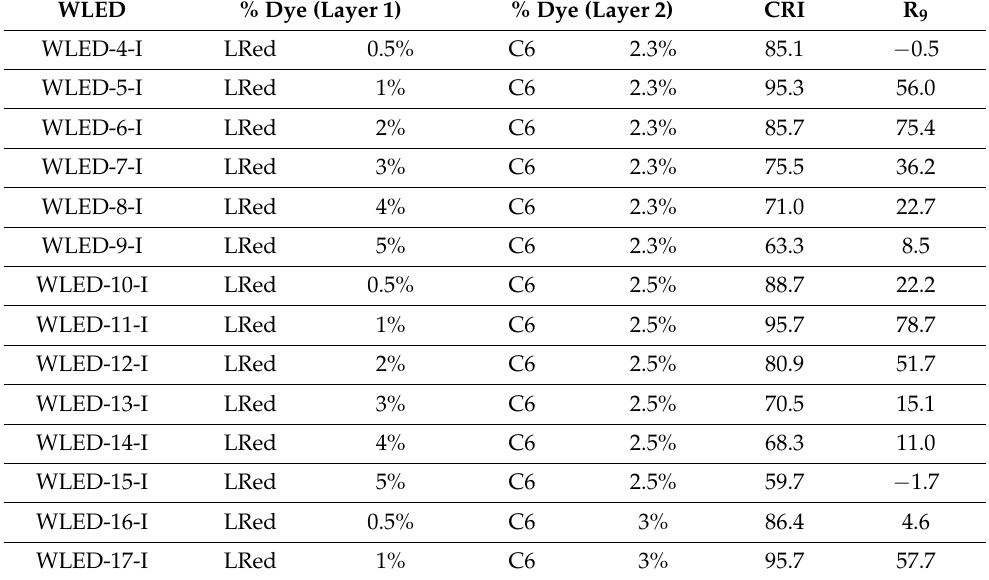
Table 3. Description of the WLEDs (4-I to 21-I) and optical